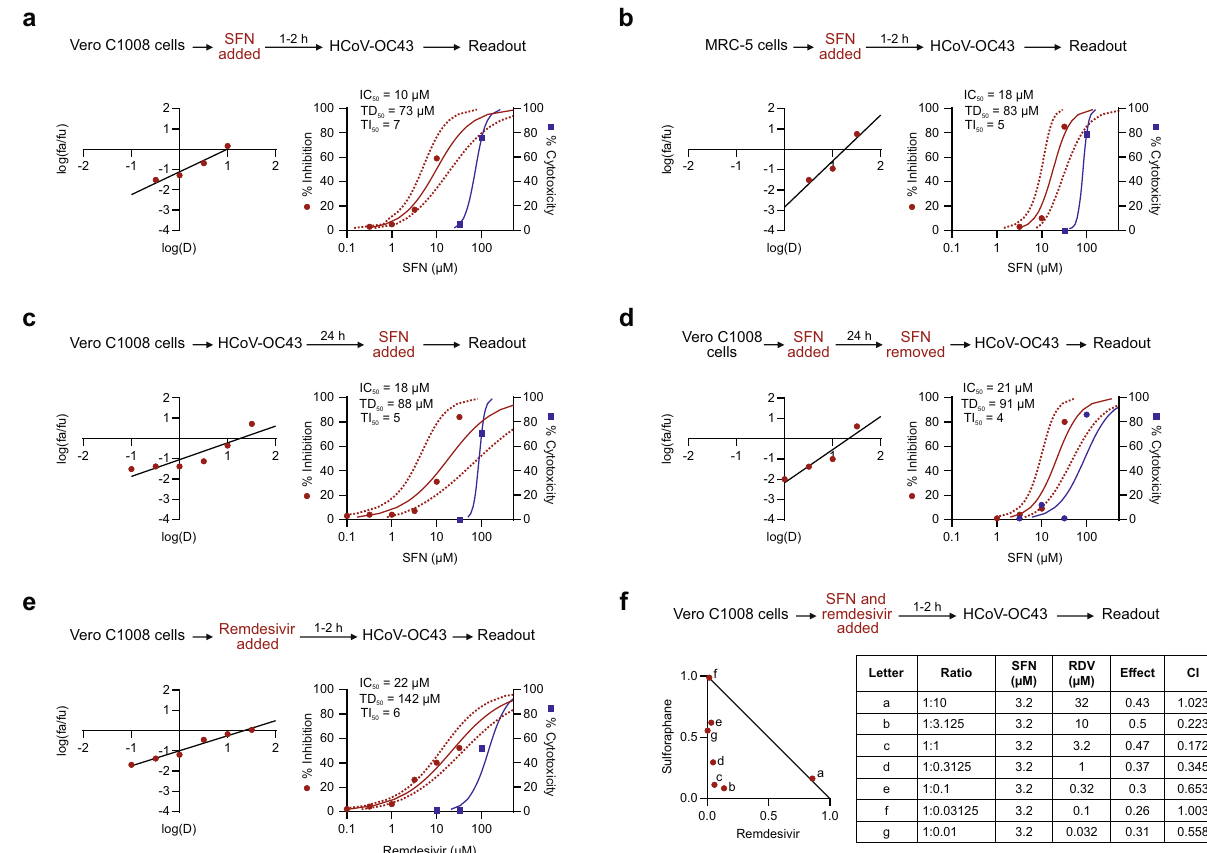
Fig. 1 Antiviral effects of SFN against HCoV-OC43. Median effect plots and dose-effect curves calculated for a Vero C1008 cells infected with HCoV- OC43 after a 1 – 2 h incubation with increasing concentrations of SFN; b MRC-5 cells infected with HCoV-OC43 after a 1 – 2 h incubation with increasing concentrations of SFN; c Vero C1008 cells infected with HCoV-OC43 over 24 h, after which they were incubated with SFN; d Vero C1008 cells incubated with SFN for 24 h, after which the drug was removed, and the cells were infected with HCoV-OC43; e Vero C1008 cells infected with HCoV-OC43 after a 1 – 2 h incubation with increasing concentrations of remdesivir. f Normalized isobologram showing combination index (CI) for combinations of various doses. Antiviral data is displayed in red; anti-host cell activity (cytotoxicity) is displayed in blue. Synergism (CI < 1); additive effect (CI = 1);